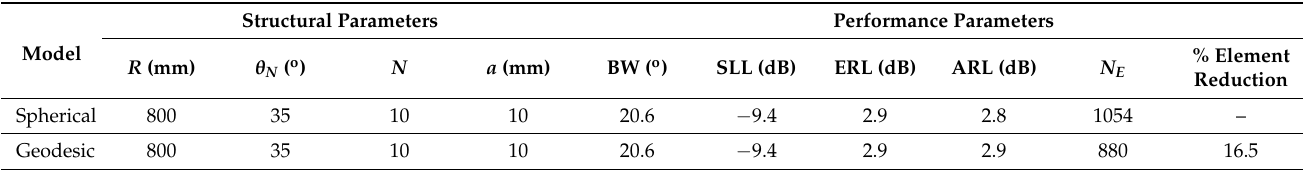
Table 8. Quantitative comparison between the SA and